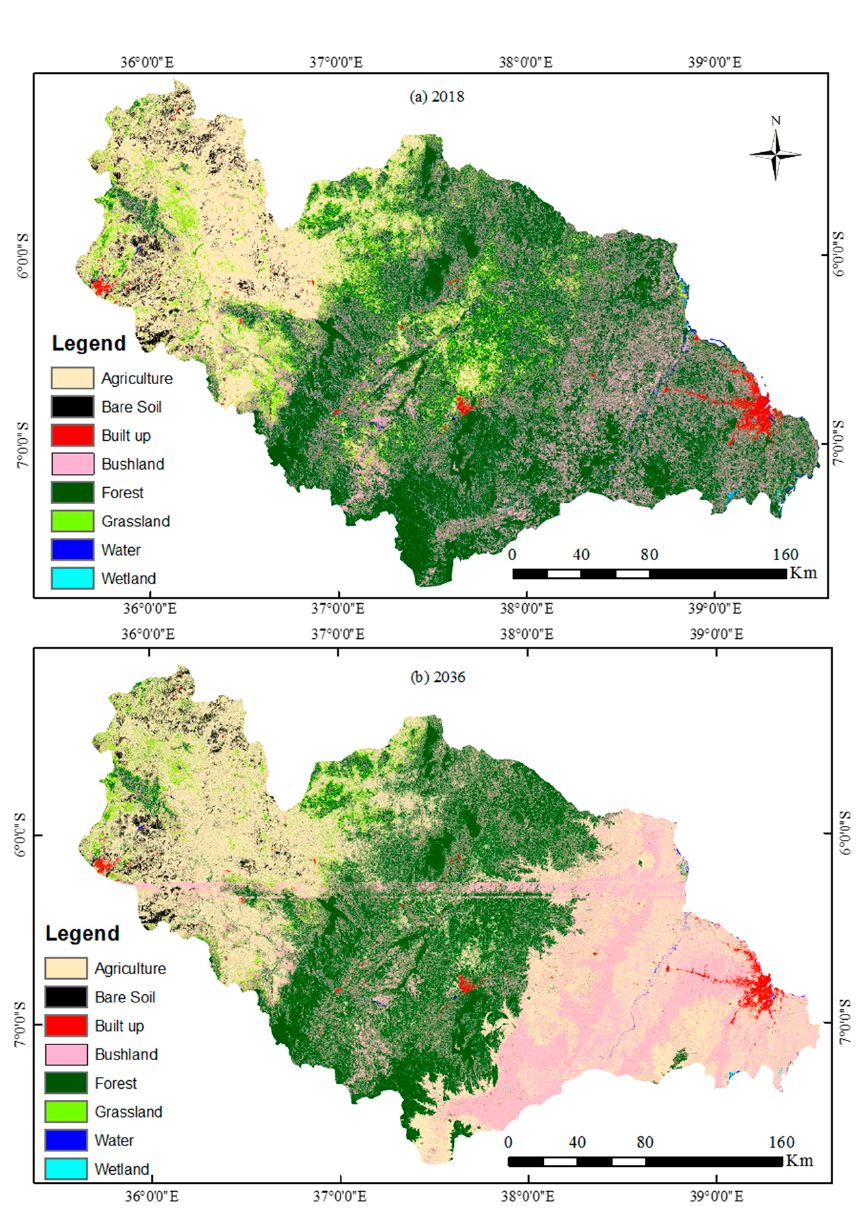
Figure 7. The LULC maps of the Wami–Ruvu Basin, ( a ) for 2018 and ( b ) projected by the CA–Markov model for the year